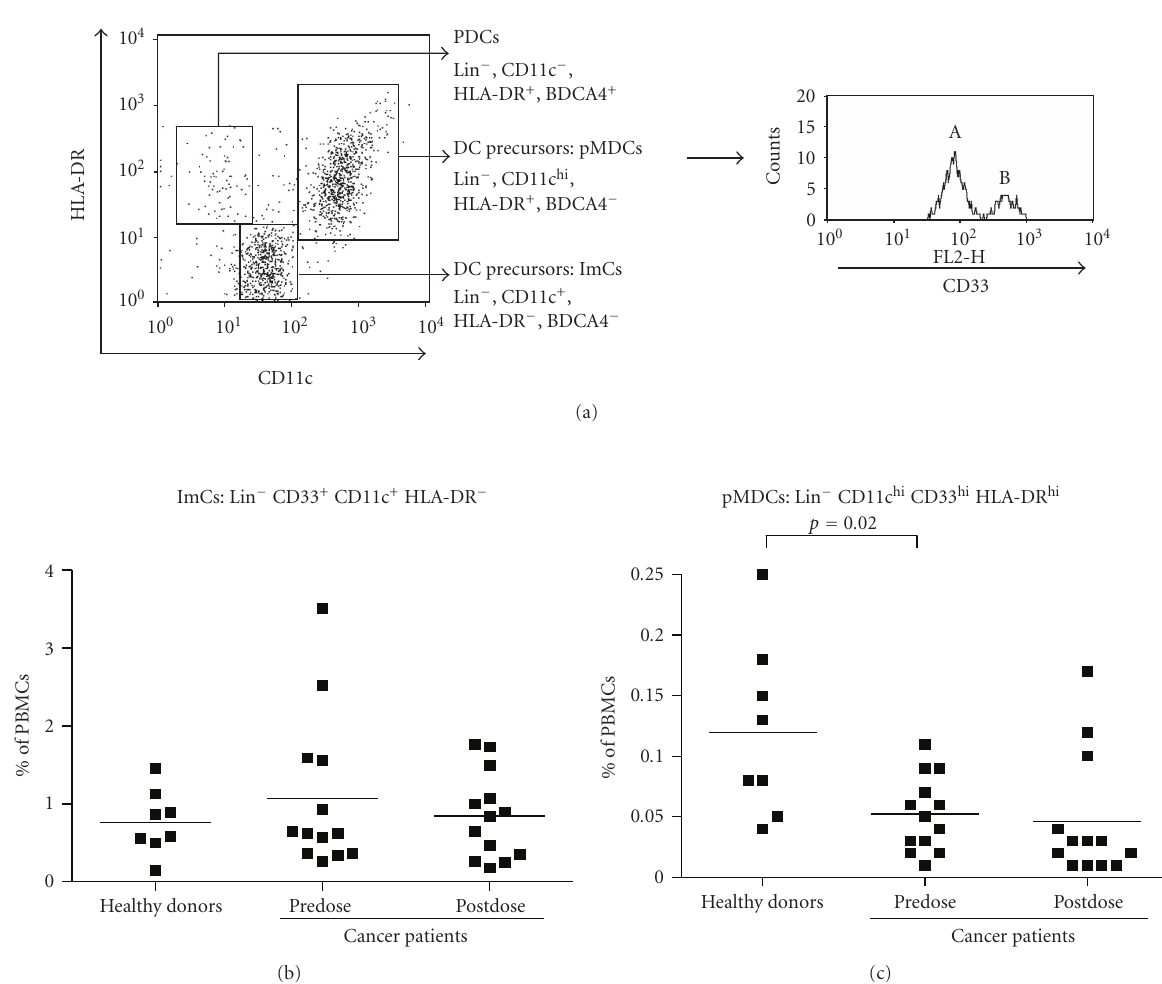
Figure 2: Typical results of blood DC analysis based on the absence of lineage (Lin) markers (CD3, CD14, CD19, and CD56) in a patient with mesothelioma. Events are gated for the absence of Lin marker expression and the presence of CD33 expression. Lin − cells, that is, immature myeloid cells (ImCs) and more mature MDC precursors (pMDC), were distinguished from plasmacytoid dendritic cells (PDC) by BDCA-4 expression (a). CD33 expression was determined for the CD11c hi HLA-DR + population. Within the HLA-DR positive population (pMDC), two subpopulations (A and B) were discernable based on intermediate and high CD33 expression (a). Results for immature myeloid cells (ImC and Lin − HLA-DR − ) (b) and mature MDC precursors (pMDC and Lin − CD33 hi HLA-DR hi ) (c) are shown for healthy donors and for cancer patients before (predose) and after VEGFR inhibition (postdose) (c). Peripheral blood DC percentages are of total peripheral blood mononuclear cells. In both graphs, individual values and the means are